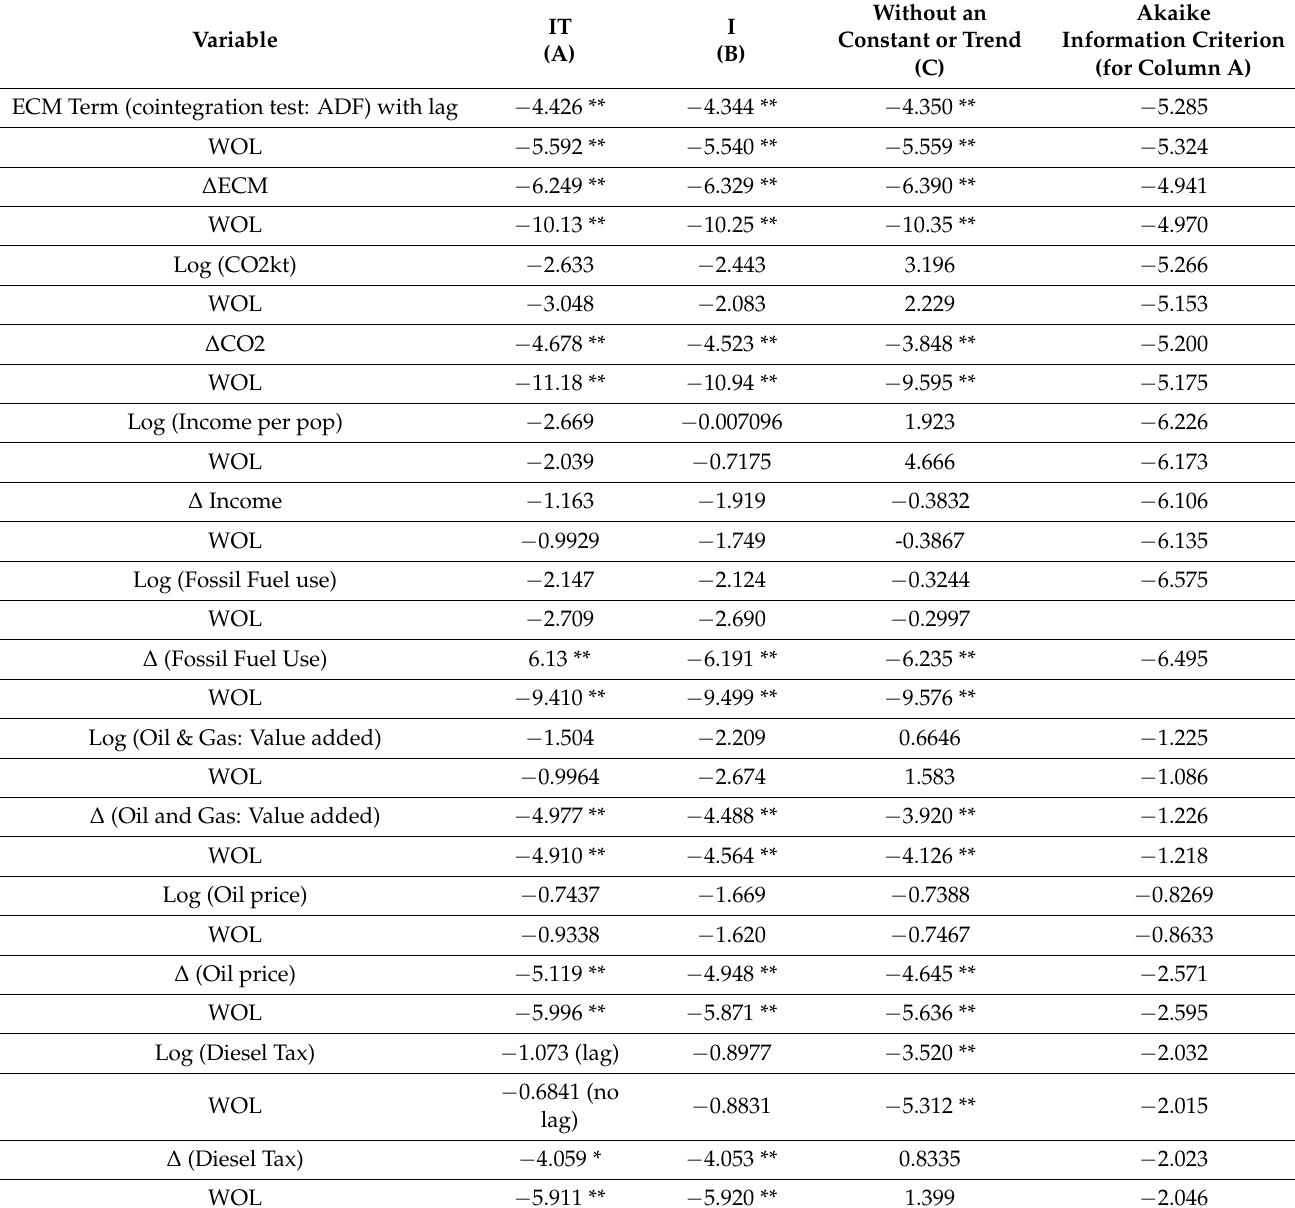
Table 8. Time series equation: Norway